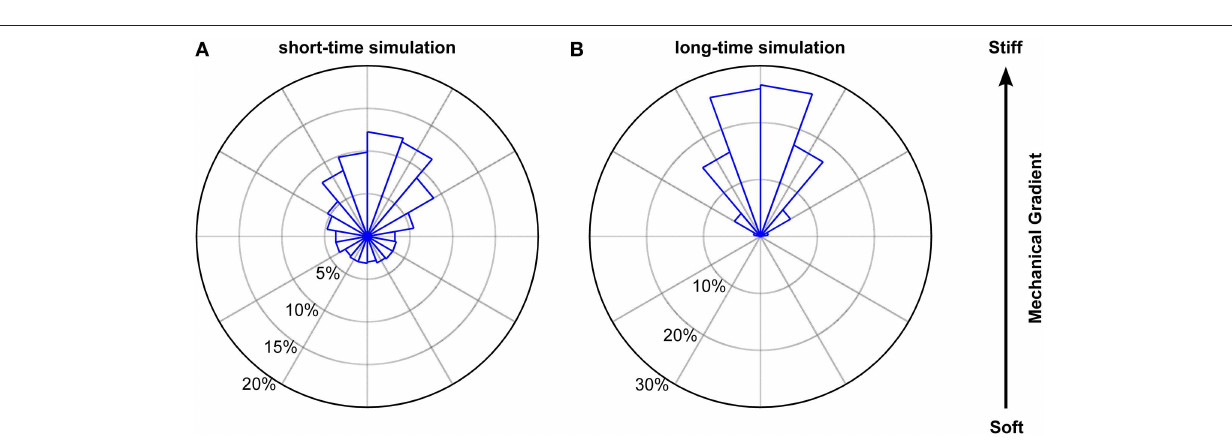
FIGURE 10 | Simulated biased random walk of microglial cells migrating on a mechanical gradient. (A) Simulation for 228 cells (6 times as many as in our experiments) with a migration time distribution matching that of the experiments. Microglia were similarly biased toward the stiffer side of the substrate as found in the experiments ( p > 0 . 1 , Kuiper’s test). (B) Simulation for 1000 cells migrating 1000min. On longer time scales, cells showed a robust migration toward the stiffer side of the gradient ( p < 0 . 01 , Kuiper’s